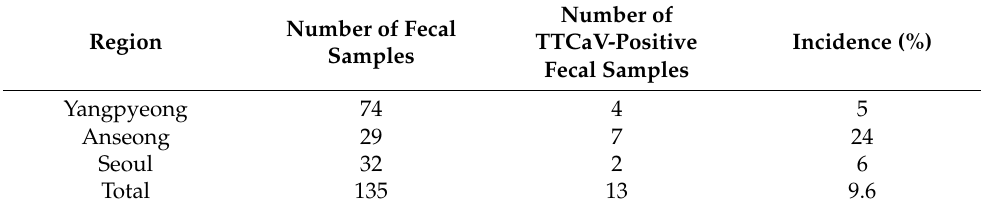
Table 2. TTCaV incidence in different regions in Republic of Korea.